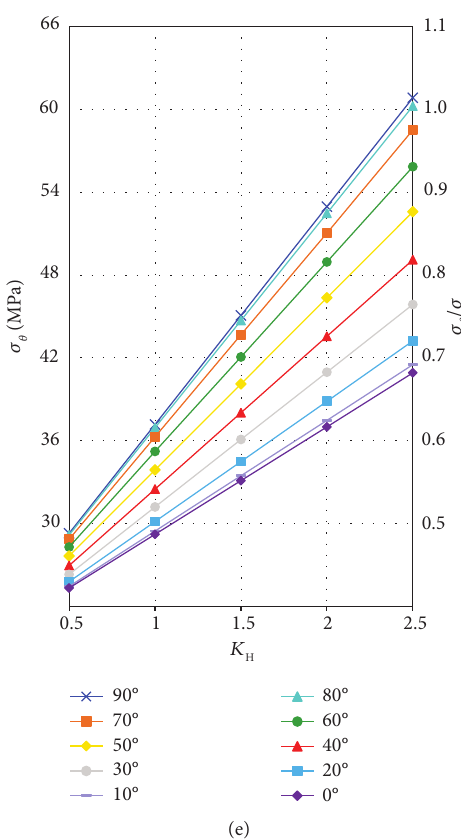
Figure 9: The tangential stress σ (b) Floor. (c) Sidewall. (d) Spandrel. (e) Corner.